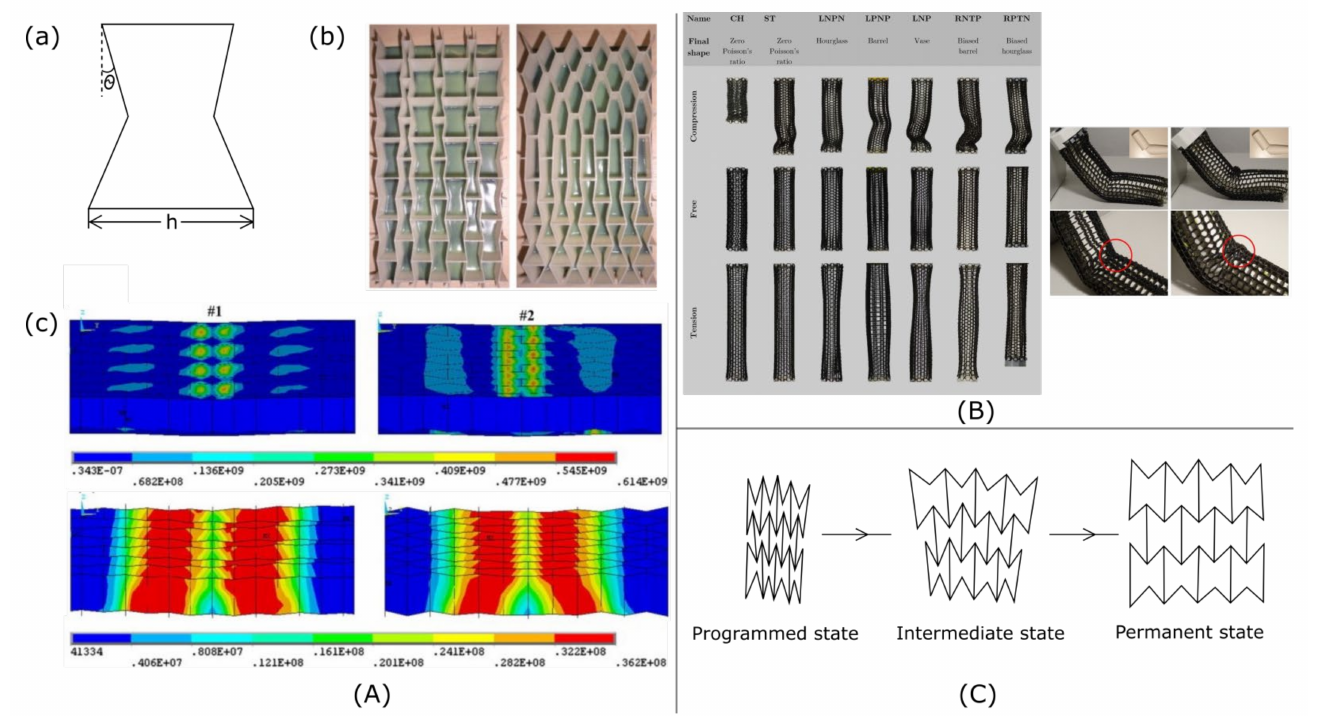
Figure 2. ( A ): ( a ) Topology of re-entrant unit cell with gradient geometry parameters: angle and horizontal length, ( b ) two geometric configurations of gradient honeycombs: #1 angle based gradient, #2 horizontal length based gradient and ( c ) nodal contour plots of Von Mises Stress of gradient sandwich panels [31], ( B ): Left: Deformation of the seven designs under tensional and compressive loads; right: Arm model covered with RNP design when ( a ) auxetic part and ( b ) hexagonal part are covering the internal part of the elbow [32]; and ( C ): Shape transformation assembled from reentrant